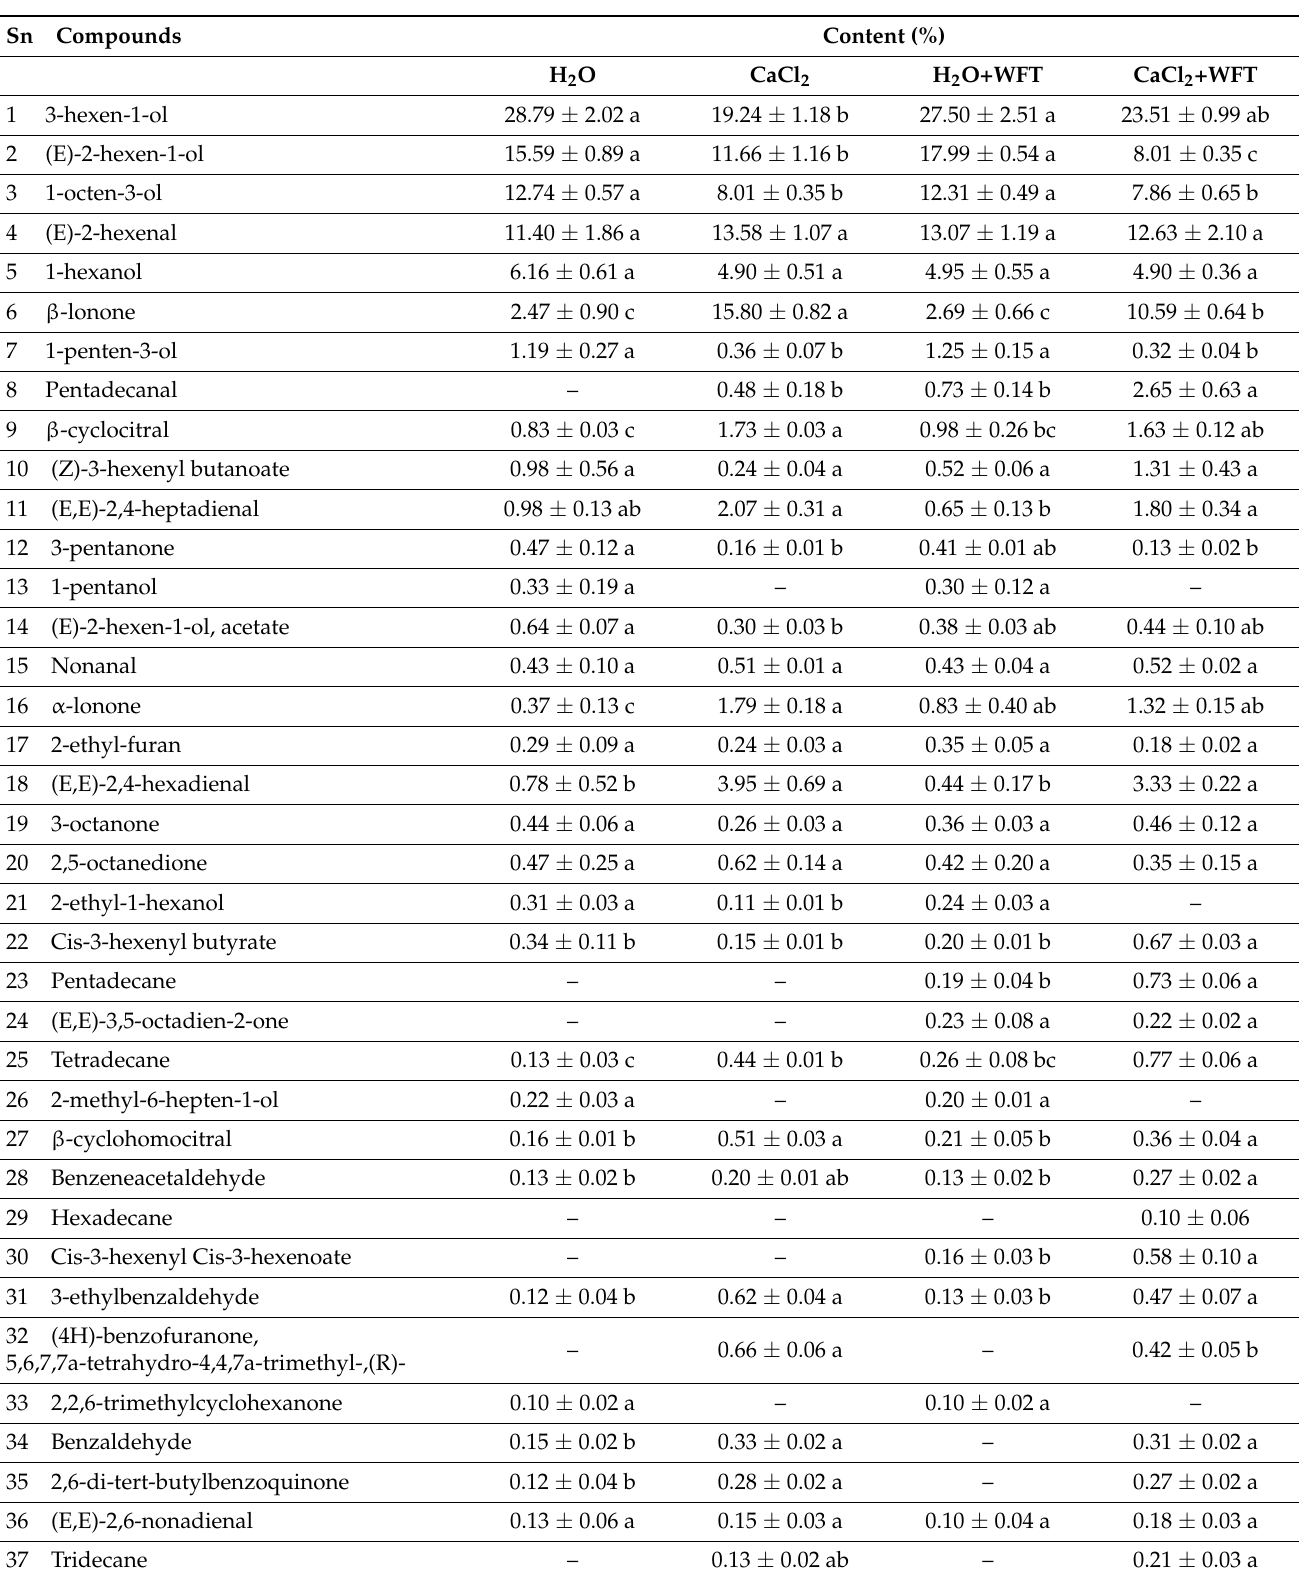
Table 1. Volatile components of kidney bean plants after four different